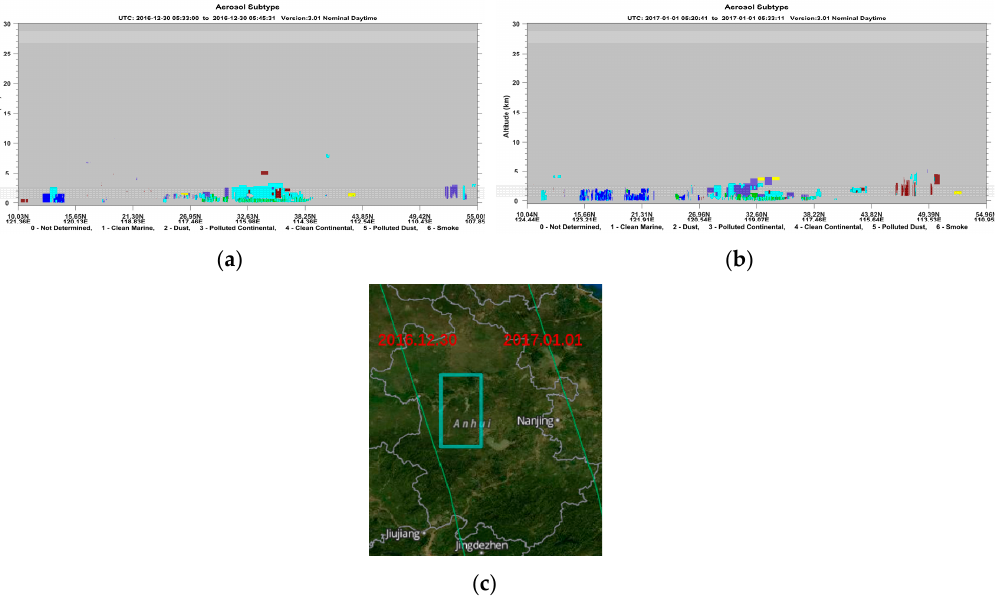
Figure 10. The vertical continuous detection of CALIPSO: ( a ) Aerosol subtype on December 30; ( b ) aerosol subtype on January 1; ( c ) the CALIPSO orbits with green lines and the Huainan region with a blue box.